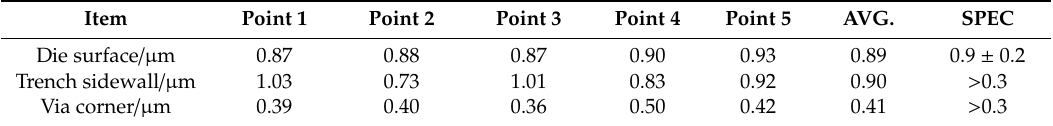
Table 7. The thicknesses of oxide in die surface, trench sidewall and via corner in PECVD process.